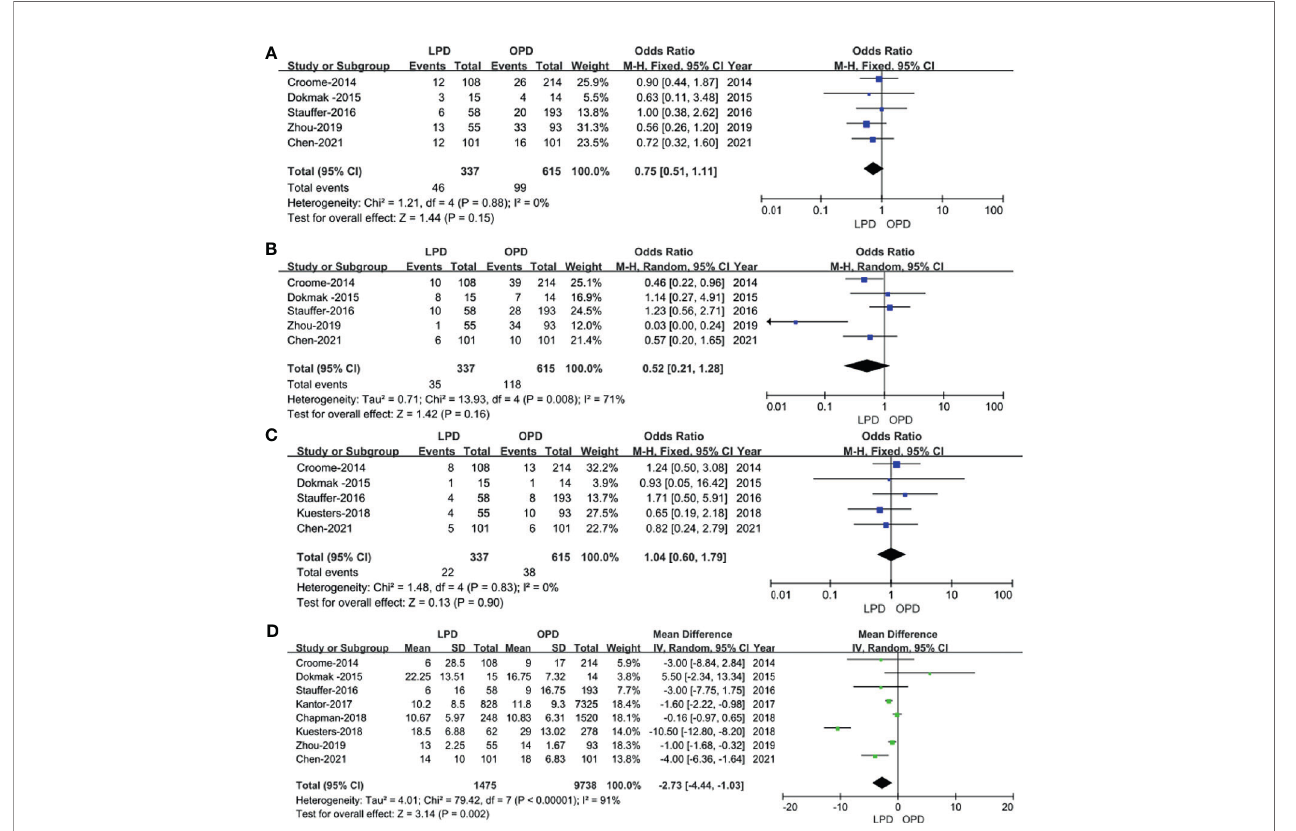
FIGURE 4 | Forest plot of the comparison of LPD versus OPD for overall complication rates. (A) Forest plot for postoperative pancreatic fi stula; (B) forest plot for delayed gastric emptying; (C) forest plot for postpancreatectomy hemorrhage; (D) forest plot for length of